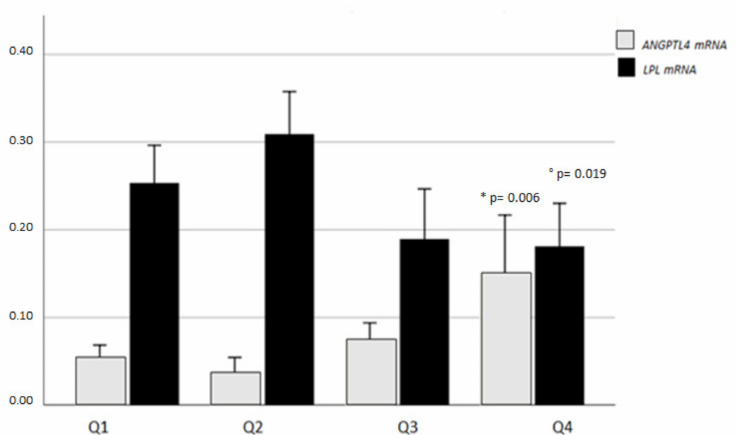
Figure 5. VAT ANGPTL4 and LPL mRNA expression levels across quartiles of vitamin D receptor (VDR) mRNA levels. Data are expressed as mean values ± standard error; *ANGPTL4 and ◦ LPL inter-group multiple comparisons, p value ≤ 0.05 is considered statistically significant. VAT VDR mRNA levels correlated positively with ANGPTL4 (r = 0.47, p < 0.001) and negatively with LPL (r = − 29, p = 0.009) levels at the bivariate analysis. Elevated VDR levels remained